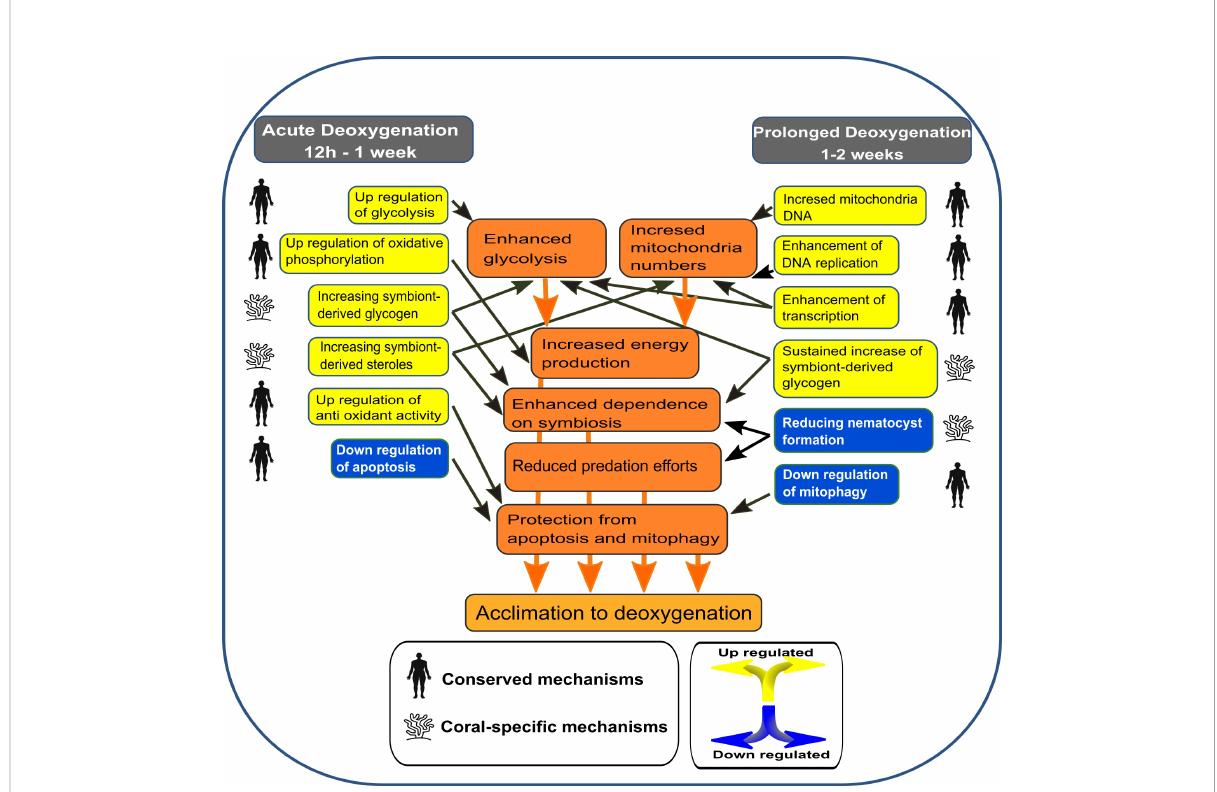
FIGURE 7 A model suggesting the cellular responses of S . pistillata to acute vs prolonged deoxygenation. The model is based on signi fi cantly enriched GO and KEGG terms, on speci fi c DE gene expressions and on relative mitochondria DNA